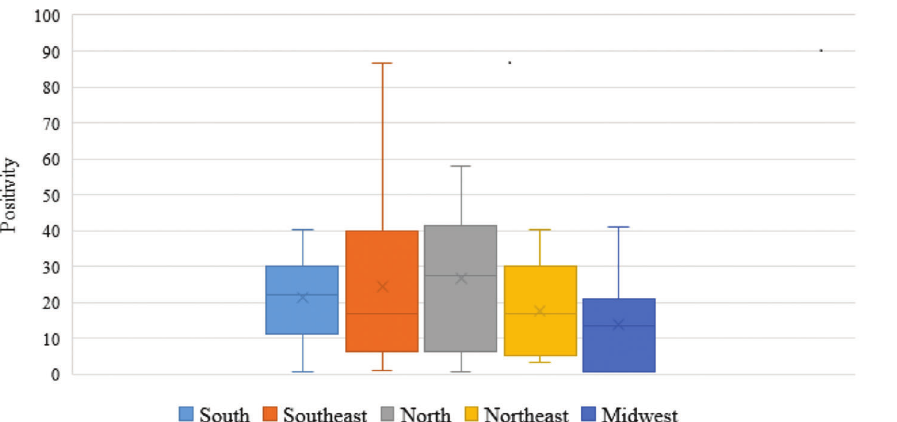
Figure 1 - Occurrence of Blastocystis sp. in fecal samples in humans based on the parasitological methods used for their detection and the region in Brazil